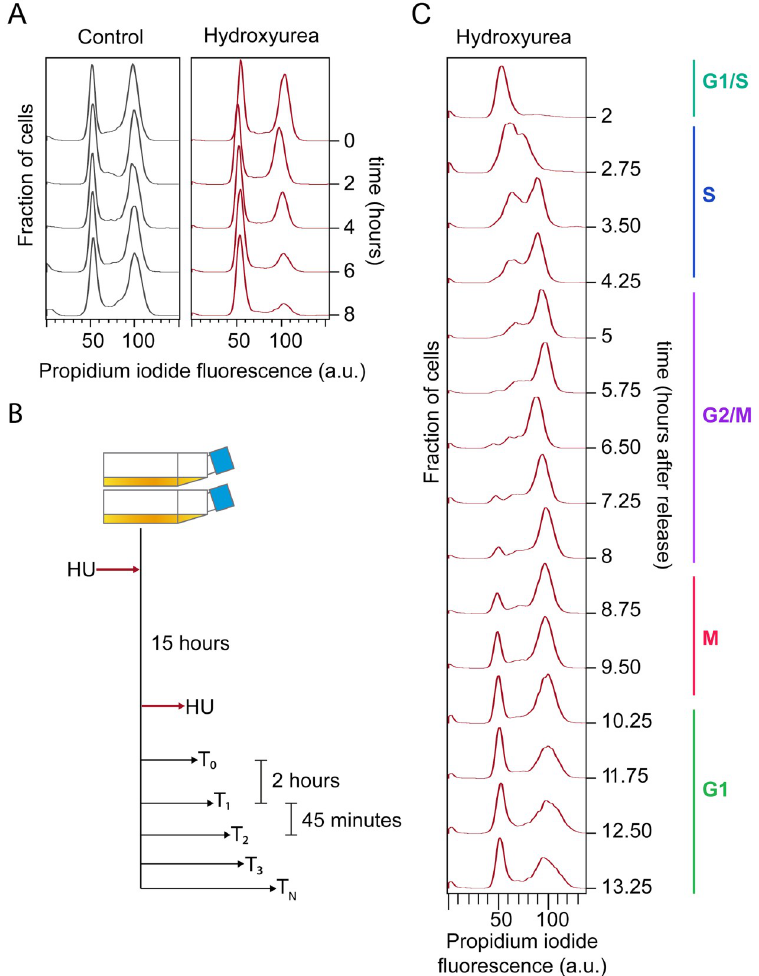
Fig 1. Experimental setup for cell cycle synchronization in Capsaspora . A : Effect of Hydroxyurea in Capsaspora cells. Control cells were treated with an equal volume of distilled water. HU treated cells were sampled every 2 hours, and a major decrease in 2C cells is observed after a minimum of 8 hours. B : Experimental layout used in this study. Two cell cultures growing independently for several generations were grown in fresh medium and kept in HU for a lapse of fifteen hours. After that, cells were released from HU and harvested every 45 minutes for 11 hours. Three different samples were taken from each culture at each time point. C : DNA content profile of synchronized Capsaspora cultures at representative time points of the whole